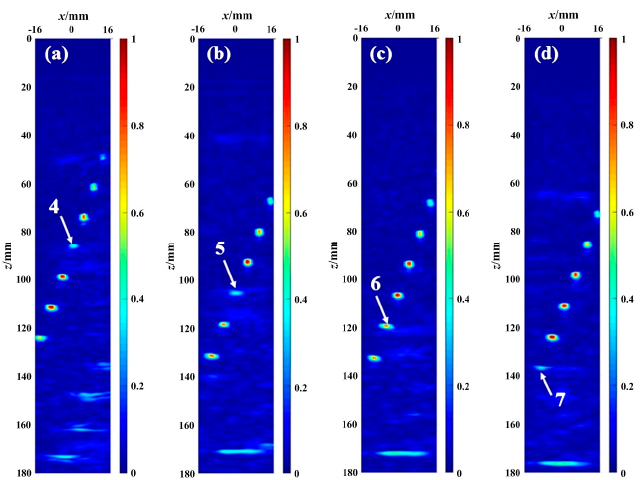
Figure 5. The PCSV factor images of different defects covered by the interface second echo: ( a ) the fourth defect covered; ( b ) the fifth defect covered; ( c ) the sixth defect covered; ( d ) the seventh defect covered.